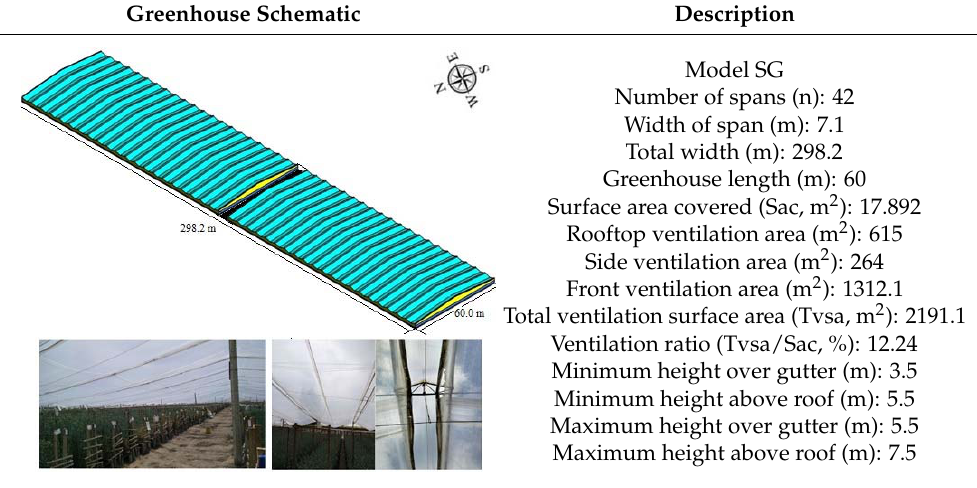
Table 6. Climate monitoring sensors used in the microclimatic characterization of the 5